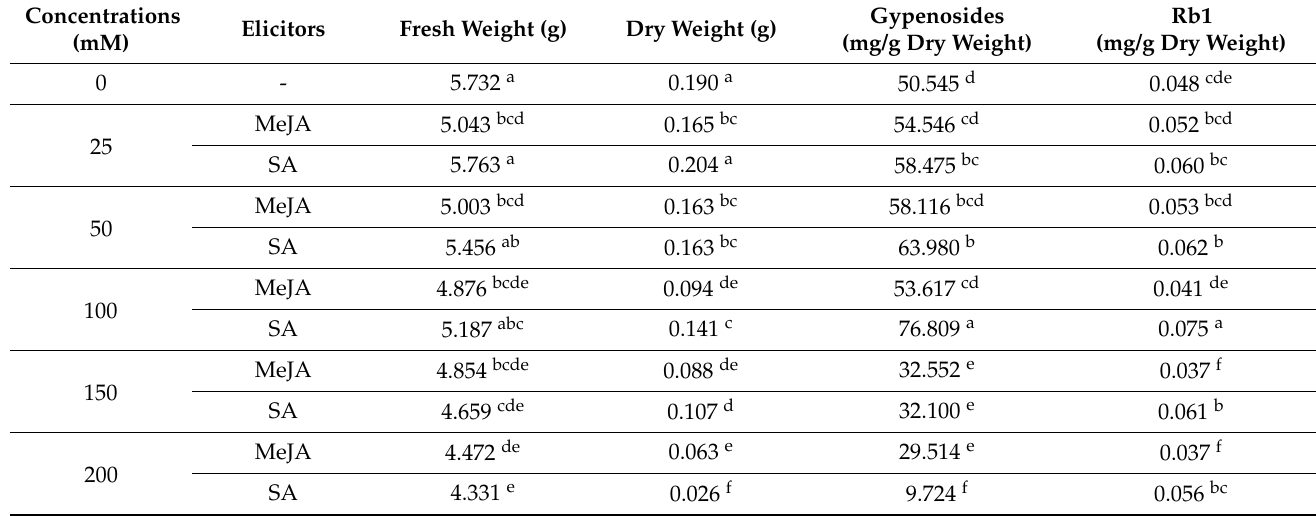
Table 1. Effects of concentrations of MeJA and SA on the cell growth and gypenosides accumulation.